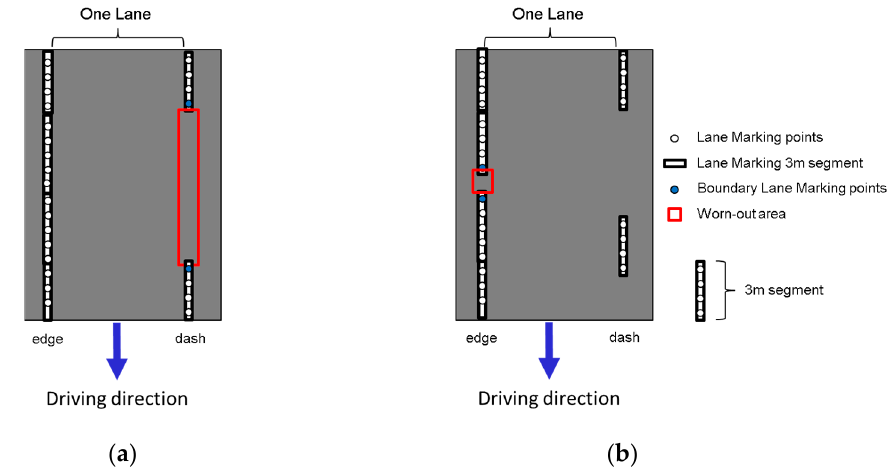
Figure 17. Illustration of gaps along ( a ) dash and ( b ) edge lines reported as short lane marking gap regions.